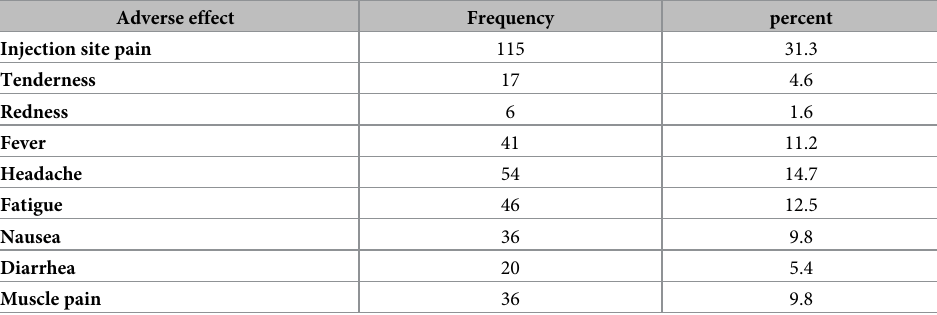
Table 6. Frequency and percent of the adverse effect of vaccines.